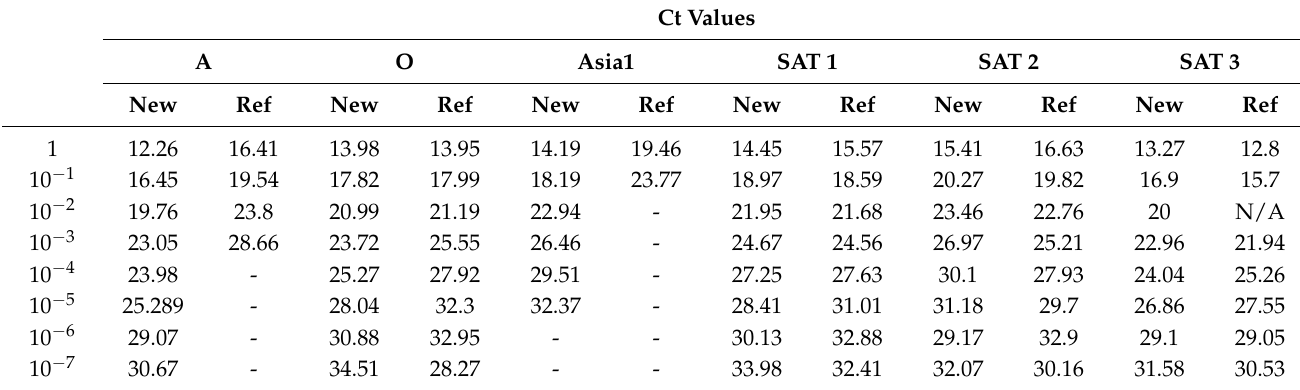
Table 2. Comparative Ct values that were obtained for FMD XF and reference assays. A total of six serotypes of FMD viruses ((A (A22/Iraq24/64), O (O1/Manisa), Asia1 (Asia1 Shamir), SAT1 (SAT1/TAN/22/2012), SAT2 (SAT2/Eritrea/98) and SAT3 (SAT3/ZIM/83)) were normalized to a titre of 4.7 log 10 TCID 50 /mL and the unprocessed virus was used in the newly designed XF assay (New) or alternately, RNA was extracted and serially diluted 1–10 − 7 that were used in the previously published reference (Ref) assay [27]. Ct values for each assay type are compared to each other based on serotype. The samples denoted with (-) are samples that failed to amplify. Standard curves follow the hypothesized linear relationship between Ct value and